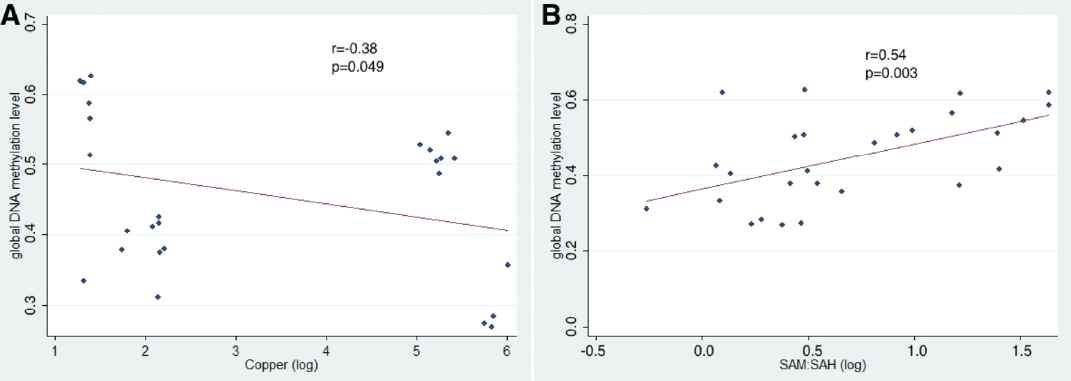
Figure 6. ( A ) Correlation between hepatic Cu concentration and global DNA methylation; ( B ) Correlation between SAM:SAH ratio and global DNA methylation (using data from 20 and 28 week old